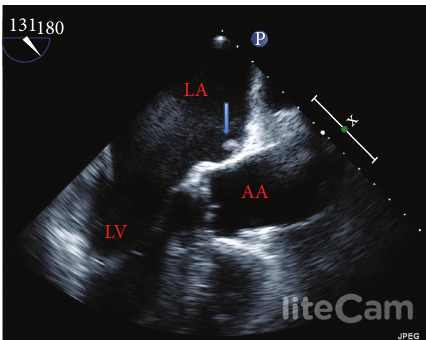
Figure 1: Transesophageal echocardiogram showing a thrombus in the left atrium (arrow). LA: left atrium, LV: left ventricle, and AA: ascending